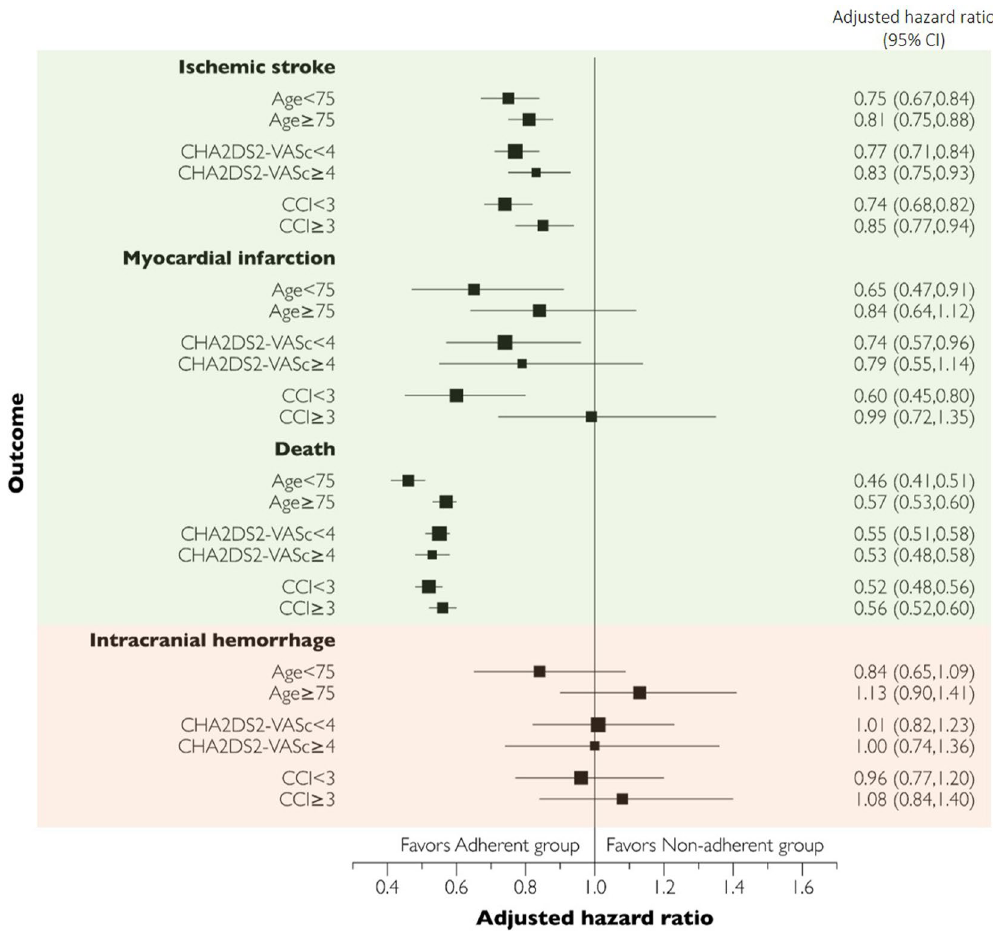
Figure 4. Hazard ratios of oral anticoagulants (OACs) from the subgroup analysis. CI, confidence